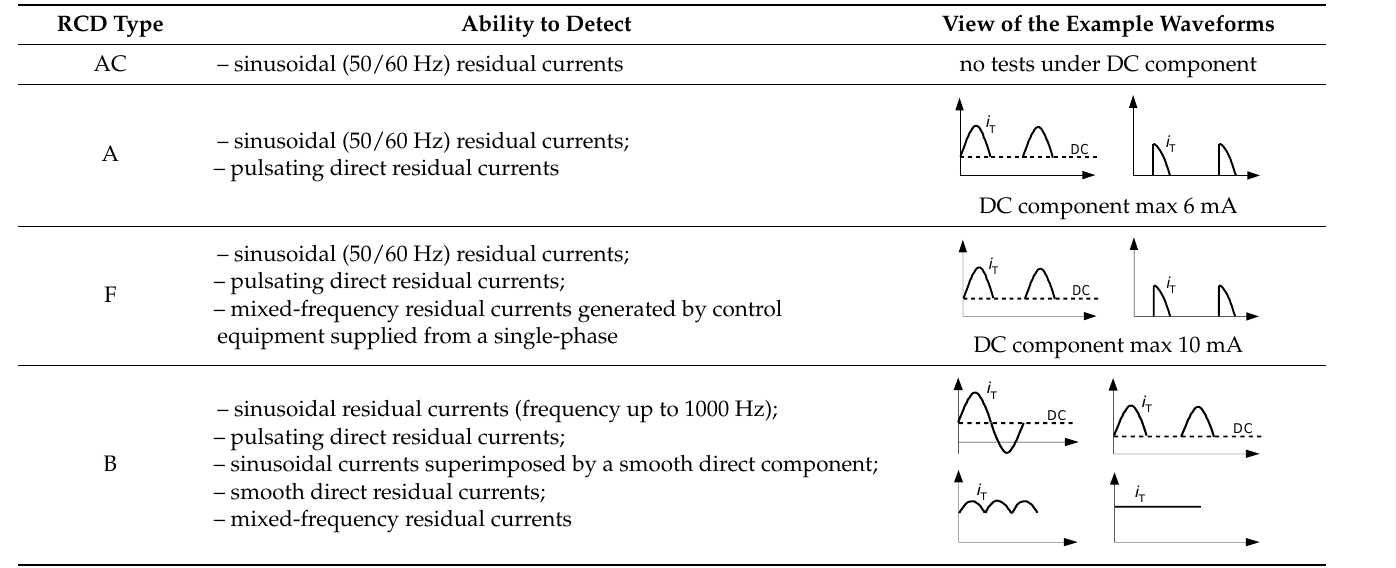
Figure 4. Simplified structure of the residual current device (RCD). RL — relay, MEE — matching electronic elements (optional), CT — current transformer (current sensor), e s — induced secondary voltage in CT, i p — primary current of the CT, i s — secondary current of the CT, i ∆ — earth fault (resid- ual) current.